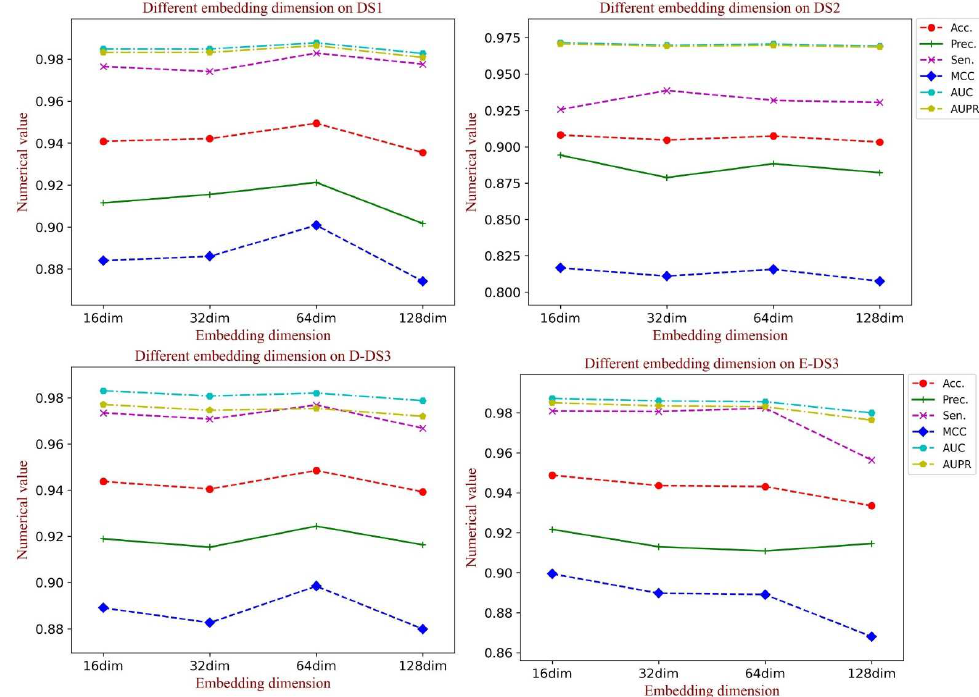
Figure 8. The performance of different dimensions of the graph embedding vector on each dataset.